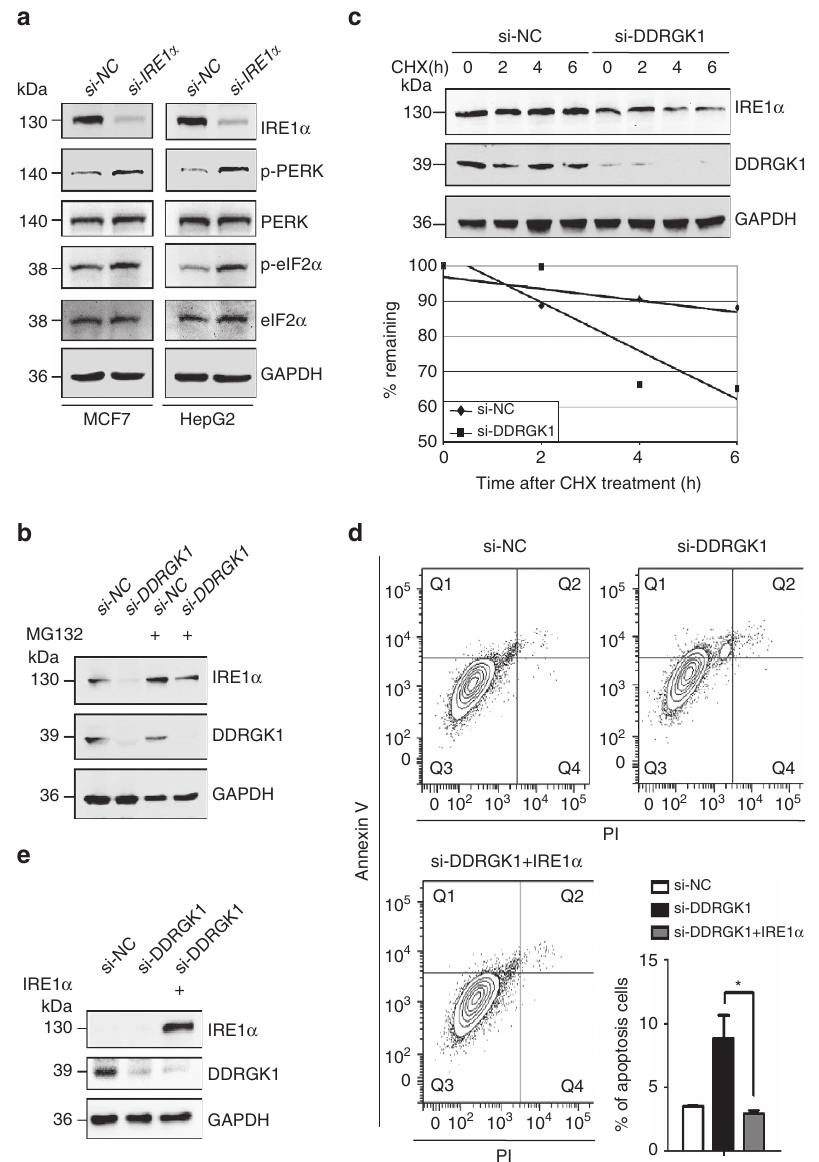
Figure 4 | DDRGK1 regulates the UPR by targeting IRE1 a . ( a ). MCF7 and HepG2 cells were transfected with either control siRNA or siRNA targeting IRE1 a for 72h. The protein levels of p-PERK, PERK, p-eIF2 a and eIF2 a were determined by western blot. ( b ). Western blot analysis of IRE1 a in control and DDRGK1-knockdown MCF7 cells treated with or without MG132 (20 m M, 8h). ( c ). Western blot analysis of IRE1 a decay in control and DDRGK1-knockdown MCF7 cells after treatment with 100 m gml (cid:2) 1 cycloheximide for the indicated times. The graph represents the quantification of the IRE1 a protein levels. ( d ) MCF7 cells were transfected with either control siRNA or siRNA targeting DDRGK1 for 72h. Before harvesting, the DDRGK1-knockdown cells were transfected with either control or IRE1 a vectors for 36h. The cells were subsequently stained with Annexin V and PI and subjected to flow cytometric analysis, followed by quantification of apoptotic cells (Annexin V þ ). All data are presented as mean ± s.d. from three experiments. * P o 0.05 by Student’s t -test. ( e ) Western blot analysis of IRE1 a in MCF7 cells in d